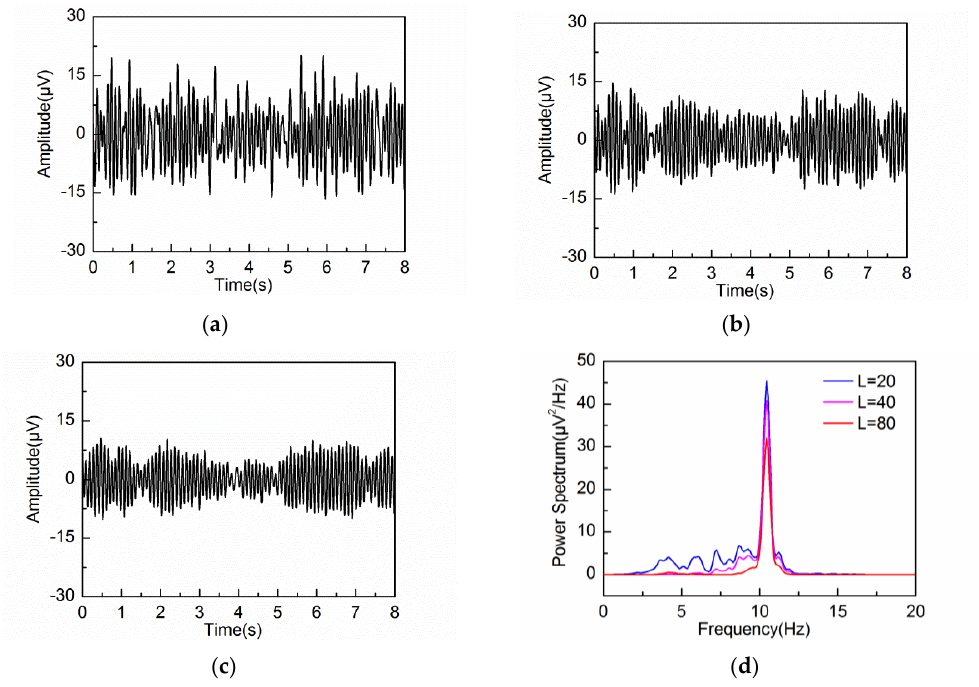
Figure 10. Extracted alpha rhythm under eyes-closed condition: ( a ) L = 20; ( b ) L = 40; ( c ) L = 80; ( d ) PSD of the extracted alpha rhythm by different